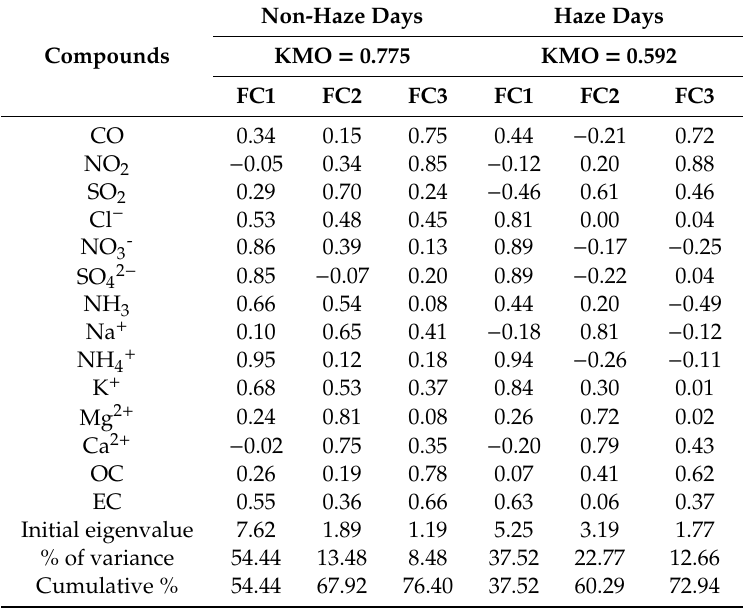
Table 2. Results of the principal component analysis